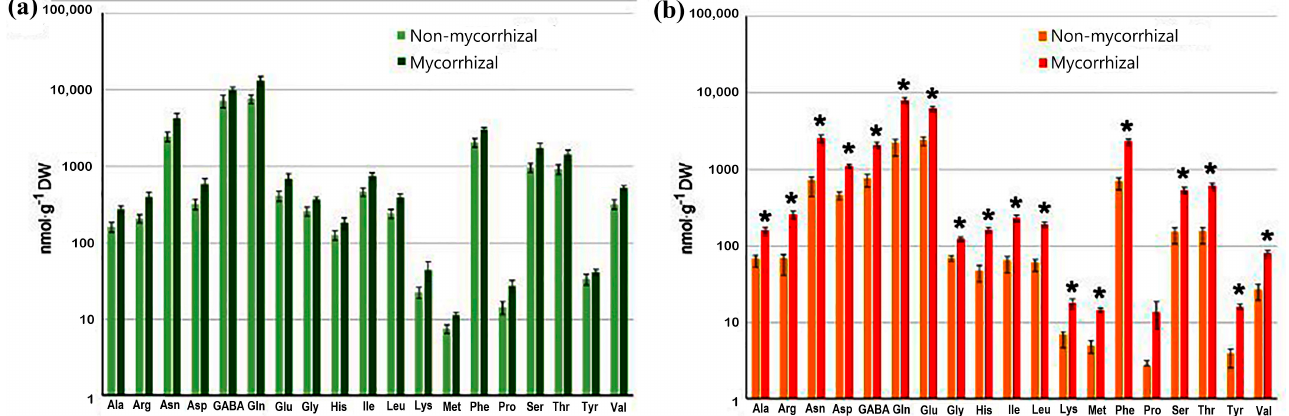
Figure 2. Amino acids in fruit tissues with and without mycorrhizae at green ( a ) and red ( b ) growth stages of fruits. The free amino acids present in the methanol-extracted freeze-dried material were determined using HPLC. Note that the amounts of amino acids in green fruits did not differ significantly. All amino acids, except for proline, were elevated in red fruits as a result of mycorrhization of plants. Data are presented as means ± SE ( n = 8). * demonstrates significant difference between fruits from mycorrhized plants and non-mycorrhized plants at p < 0.05.